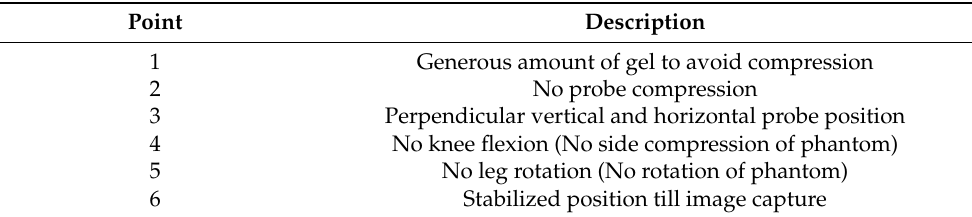
Table 1. Points of ultrasound